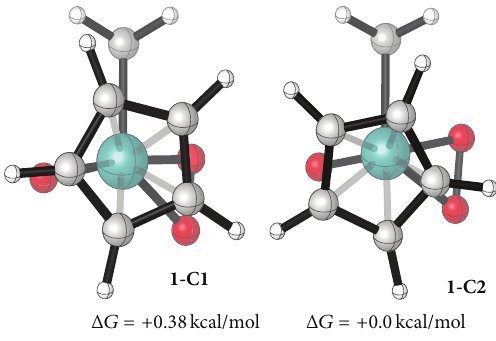
Figure 1: Illustrating the conformation differences.